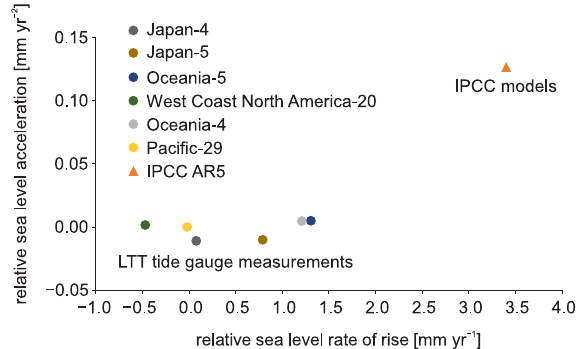
Fig. 3. Relative sea level rate of rise and acceleration of the long-term trend (LTT) tide gauges of the Pacific. On average, the relative rate of rise and acceleration are both negative, −0.02139 mm yr −1 and −0.00007 mm yr −2 ,